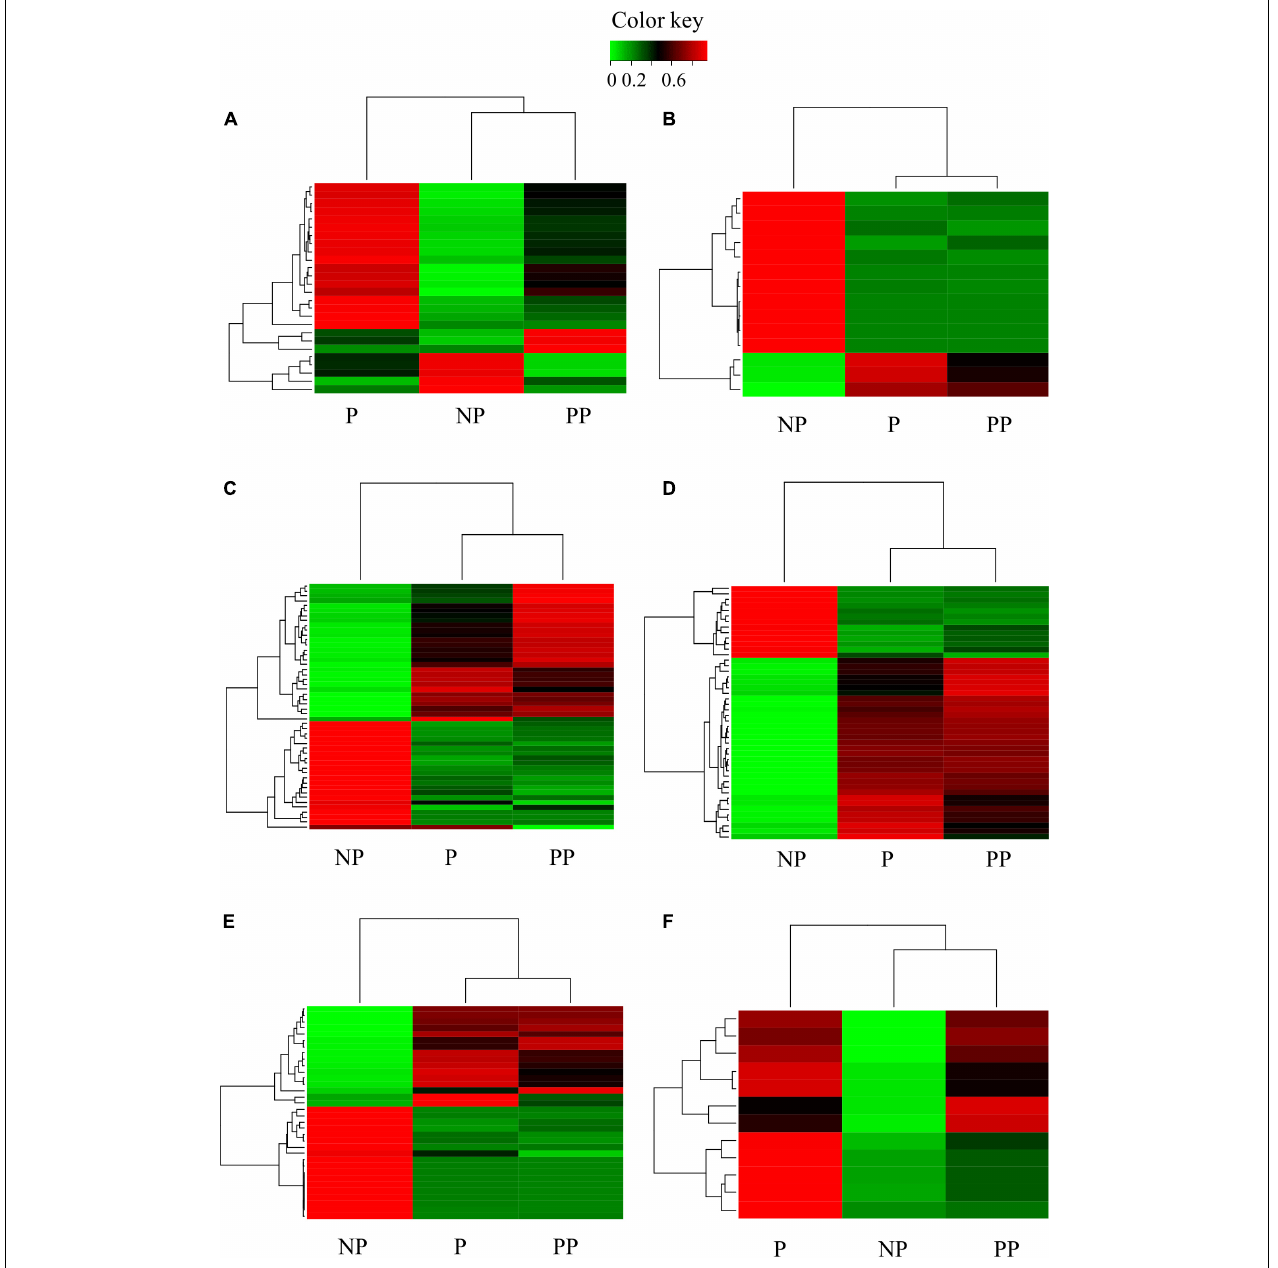
FIGURE 7 | Heatmap of immune response transcripts of larvae of Diatraea saccharalis parasitized (P) and pseudoparasitized (PP) by Cotesia flavipes : (A) AMPs synthesis; (B) cellular response; (C) immune system activation; (D) immune system inactivation; (E) peptidoglycan recognition; (F) phenoloxidase